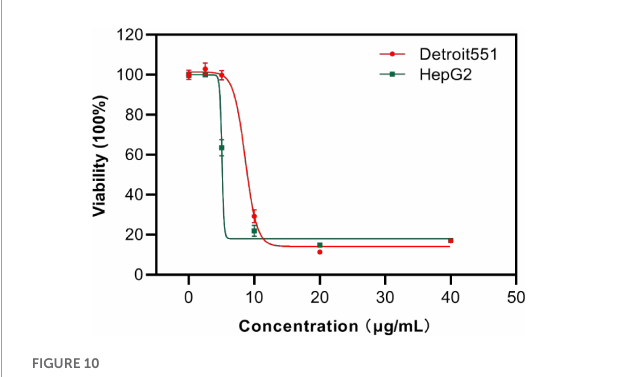
FIGURE10 Cytotoxicity of S2303 against skin cells and liver cancer cells. Cytotoxicity of S2303 against skin cells and liver cancer cells. Detroit 551 is the human skin cell, and HepG 2 is the liver cancer cells, which are shown in red and green, respectively. Cells (5,000 per well) were seeded into 96-well plates and treated with S2303 of different concentrations for 24 h. Viability of cells was determined as a function of redox potential by MTT assay. Data were analyzed using GraphPad Prism